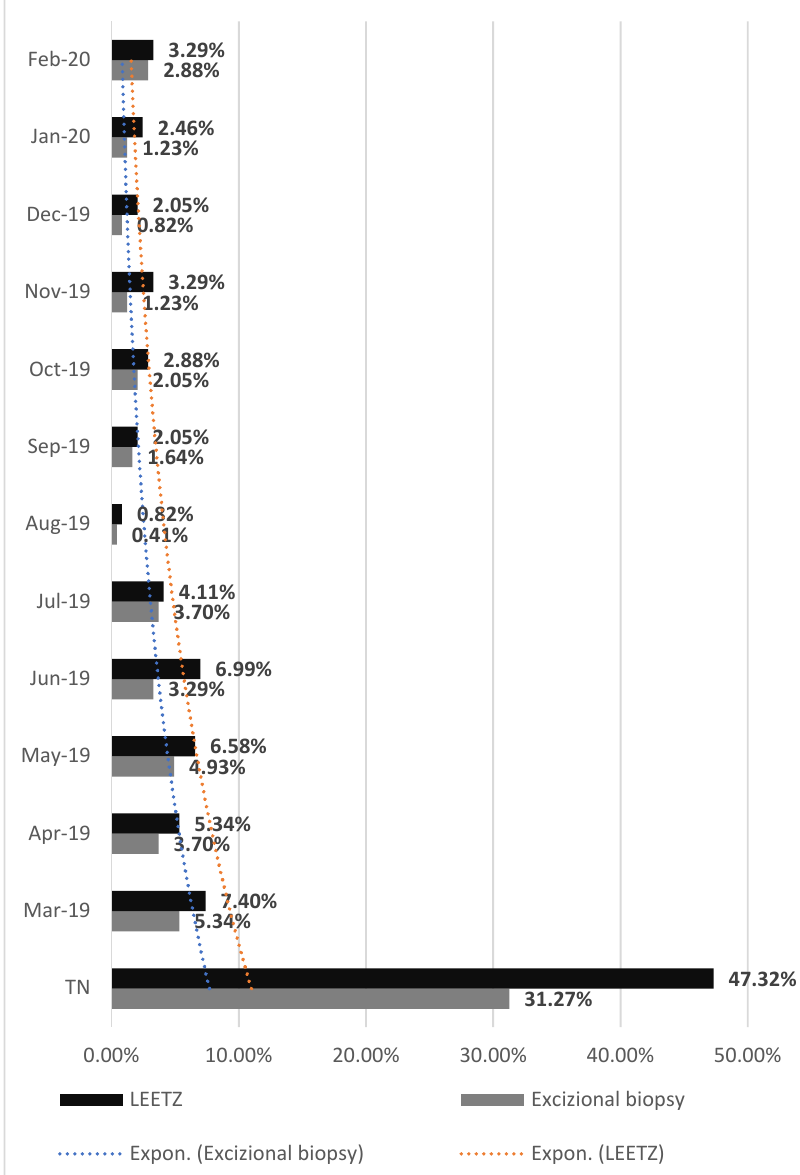
Figure 6. Surgical procedures performed in both clinics of the Emergency County Hospital in the year before the SARS-CoV-2 pandemic. NPP: non-pandemic period; LEETZ: Large loop excision of the transformation zone; TN: Total number of surgical procedures performed.